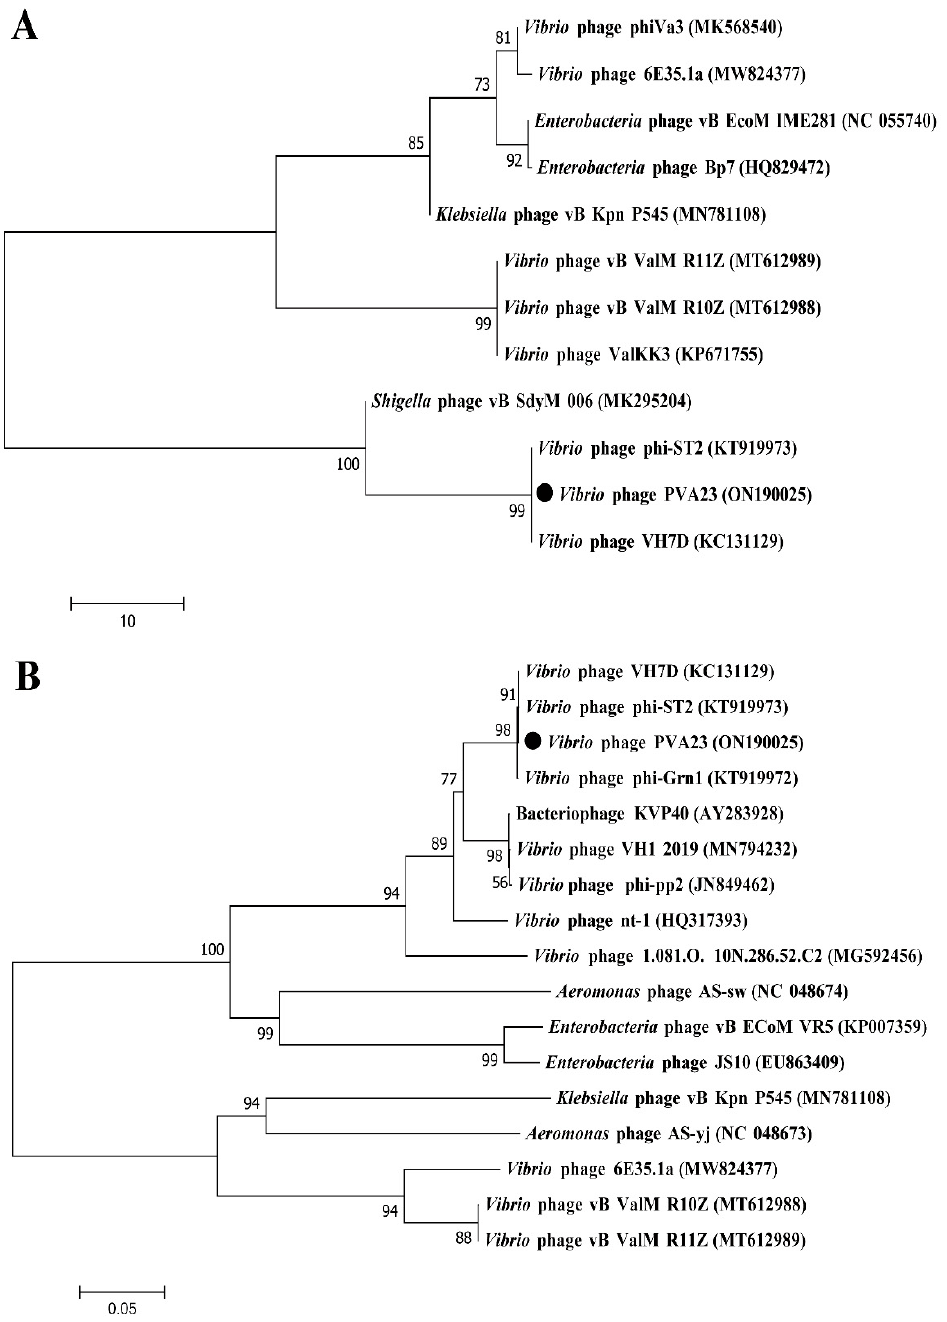
Figure 8. Phylogenetic analysis of phage PVA23. The phylogenetic tree was constructed using the Maximum Likelihood method with 1000 bootstrap replicates. ( A ) Phylogenetic tree was constructed based on the major capsid protein; ( B ) Phylogenetic tree was constructed based on the terminase large subunit.